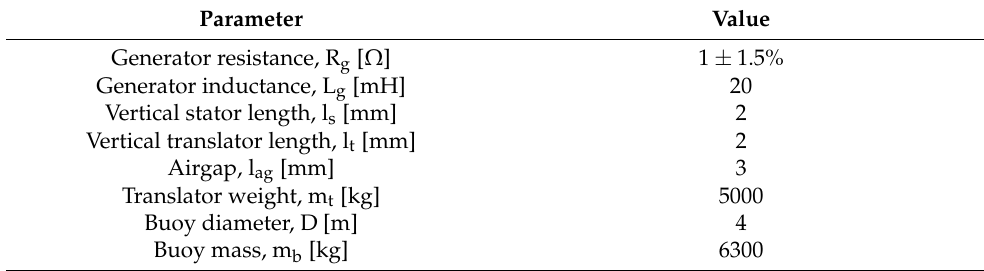
Table 1. Wave energy converter (WEC) specifications. Parameter Value Generator resistance, R g [ Ω ] 1 ± 1.5% Generator inductance, L g [mH]